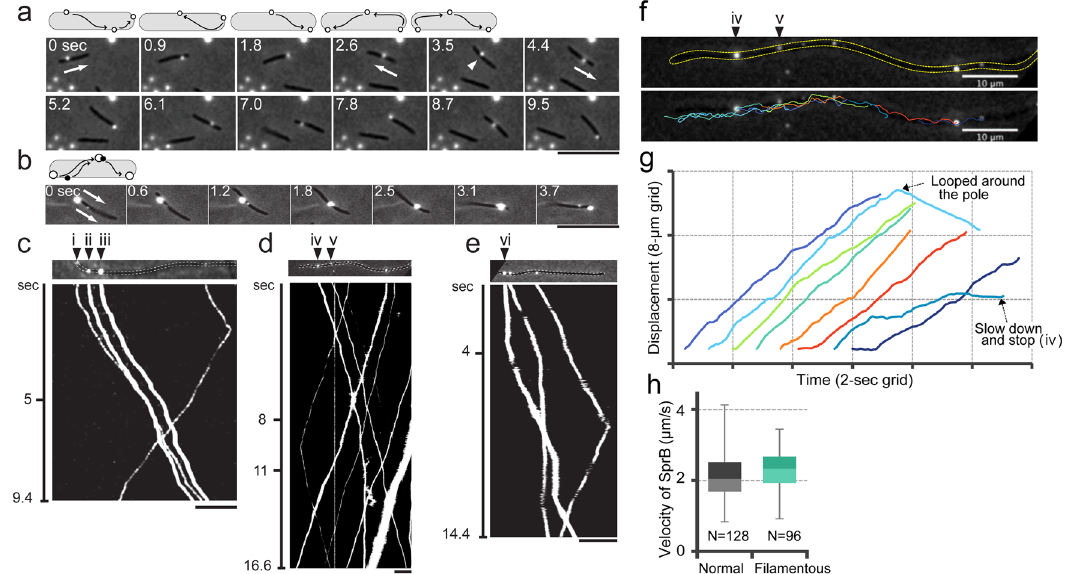
Fig. 2 Patterns of SprB movement on gliding cells. Limited numbers of cell-surface SprB proteins were immunolabeled using low-concentration antiserum against SprB and Alexa Fluor 555-conjugated anti-rabbit IgG secondary antibody and observed by phase-contrast fl uorescence microscopy. Cell outlines were visualized by simultaneous weak illumination using a halogen lamp. SprB signal movements are depicted by time-lapse montage images and kymographs. a U-turn of SprB. b Passing of one SprB signal by another. Arrows indicate the direction of movement of SprB signal, and white arrowhead indicates the turn position of SprB signal. c – e SprB movements on elongated cells. F. johnsoniae wild-type cells were grown in the presence of 20 μ g per ml of cephalexin for 6 h and labeled with anti-SprB antiserum and Alexa Fluor 555-conjugated anti-rabbit IgG secondary antibody. c Kymograph demonstrating passing of one SprB signal by another on a fi lamentous cell. The kymograph was generated from Supplementary Movie 8, which was taken by phase- contrast fl uorescence microscopy. d Kymograph of slowdown-and-stop movement of SprB from Supplementary Movie 9. e Kymograph of stay-and-go movement of SprB from Supplementary Movie 10. The x axis and y axis of kymographs represent the positions of SprB signals and elapsed time, respectively. The cell image and the x axis of the kymograph in each panel are the same scales. f Tracking of SprB movement in panel ( d ). Outline of a fi lamentous cell is shown by dashed yellow line. Moving trajectories of SprB signals are colored and overplayed on the cell image. g Time course of SprB movement along the long axis of cell. Each colored line represents the moving trajectory of SprB with the same color in panel ( f ). Looped around the pole and slowdown-and-stop movements are indicated by arrows. h Effect of cephalexin on the velocity of SprB. Box plot represents the minimum value, 25th percentile, median, 75th percentile, and maximum value of the SprB velocity. Bars indicate 10 µ